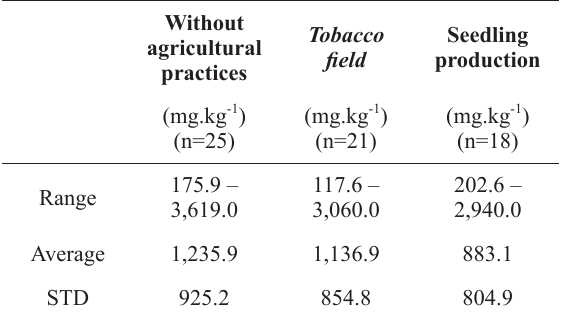
Total Mn results of soil samples according to origin (without agricultural practices, Tobacco field and seedling